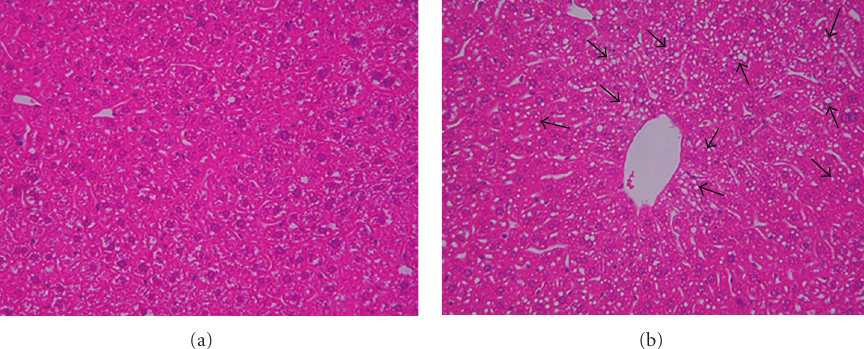
Figure 1: Liver Histology . The fixed liver sections of mice fed with regular (a) or ethanol-containing (b) Lieber-De Carli liquid diets were stained with hematoxylin and eosin (a, b), as described in Materials and Methods (original magnification 20X). The arrows indicate steatosis